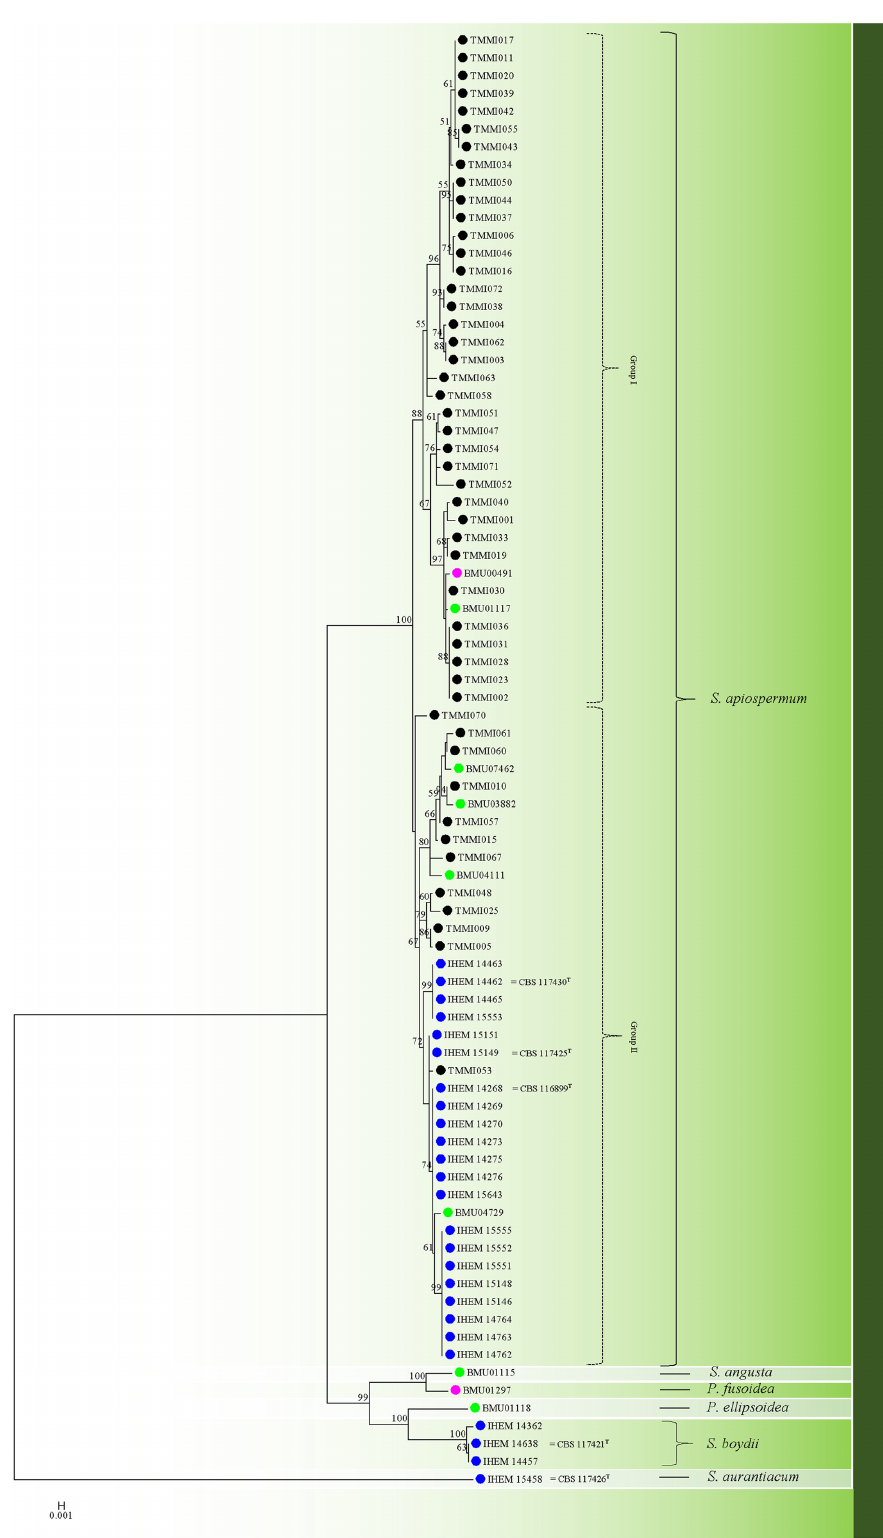
Fig 3. Molecular phylogenetic maximum likelihood analysis of the concatenated sequences of ACT, CAL, RPB2, BT2 and SOD2 genes. The tree with the highest log likelihood (-1105.3764) is shown. The